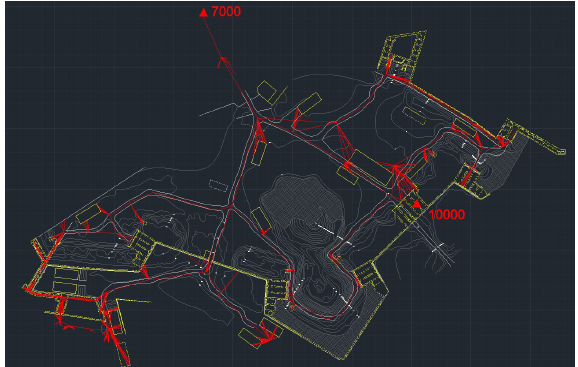
Figure 5. topographic network (redlines). The point 7000 and 10000 are the two point for the coordinate system